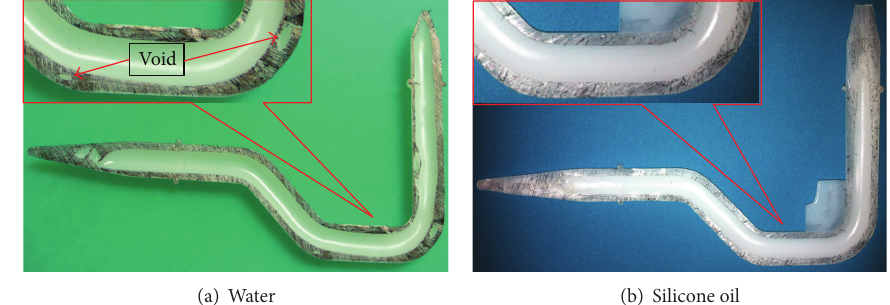
Figure 10: Comparison of experiment result between water and silicone